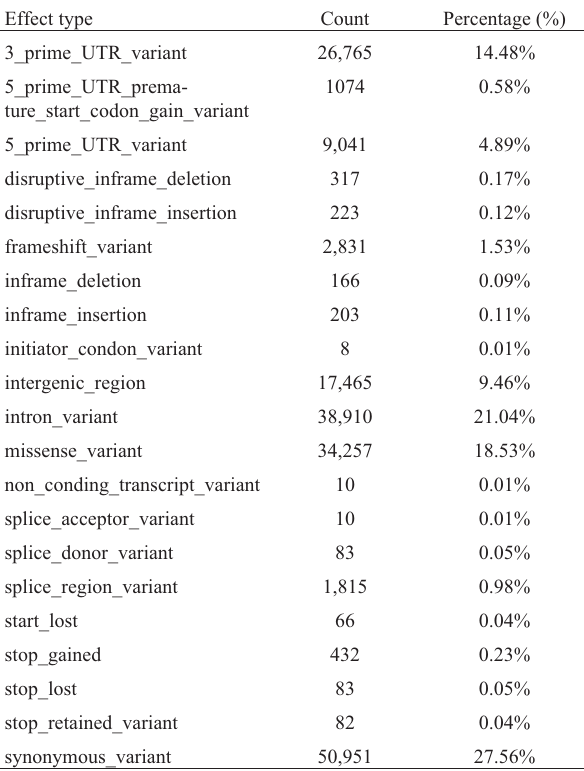
Table 2 - Number of effects by type according to SnpEff